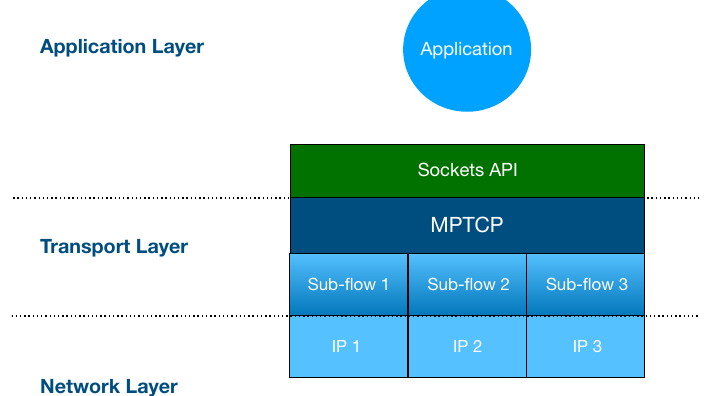
Figure 4. MPTCP in the Networking